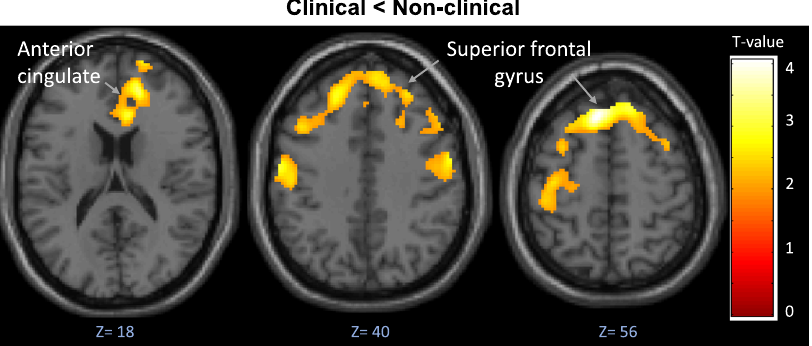
Fig. 2 Areas showing reduced activity in the clinical group compared with the non-clinical group during the Telepath task. Cluster- forming threshold FWE-corrected p = 0.02; whole brain voxel threshold p < 0.05 uncorrected. Contrast: Think how this was done > Rest. Table 2. Group differences in fMRI activity (Contrast: Think how this was done > Rest; whole-brain threshold p < 0.05 uncorrected). Cluster size (Voxels n